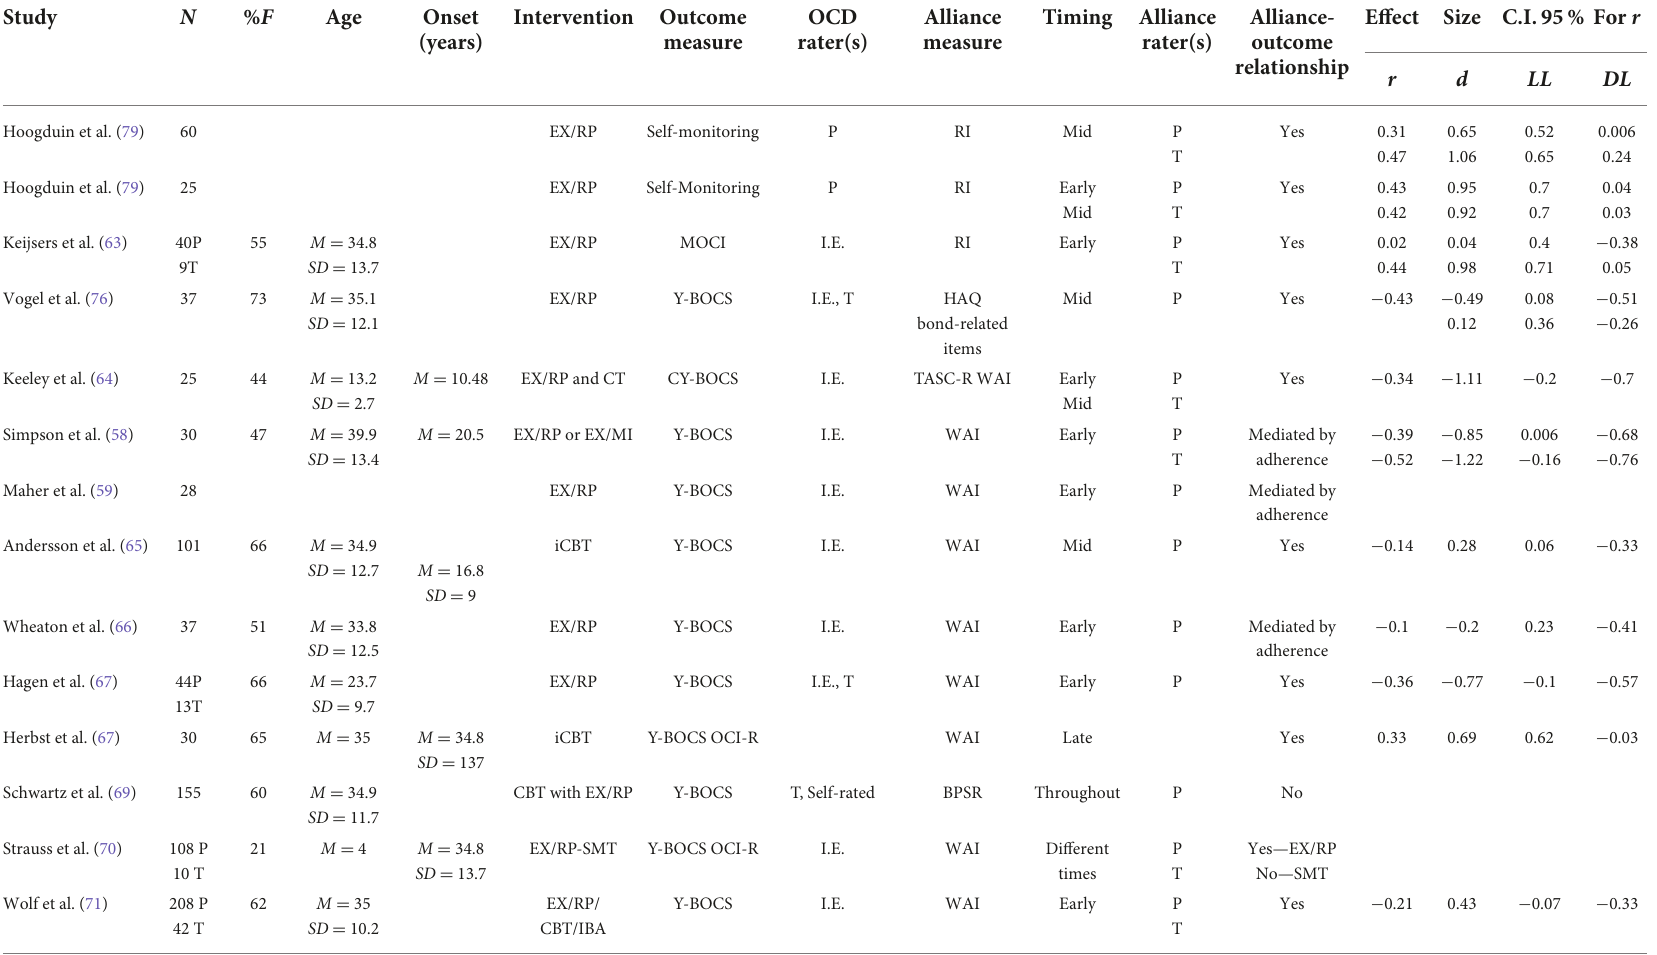
TABLE 1 Synthetic description of studies that have examined the influence of therapeutic alliance on treatment outcome.